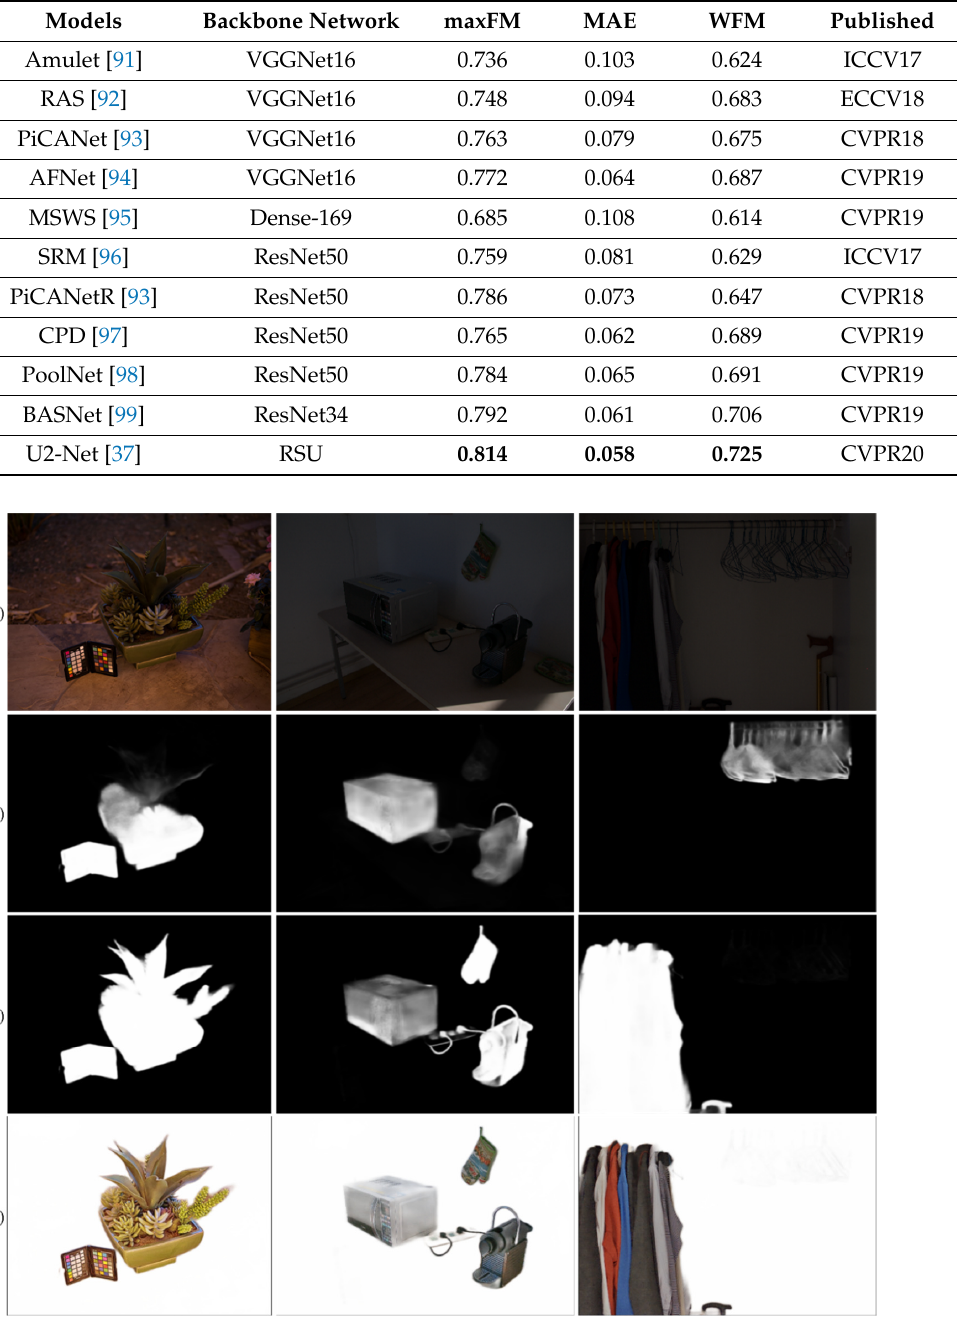
Figure 16. The results of salient object extraction model on the challenging LOL datasets. ( 1 ) low-light input images; ( 2 ) salient object extraction before image enhancement; ( 3 ) salient object extraction after image enhancement; ( 4 ) salient objects in full color space.